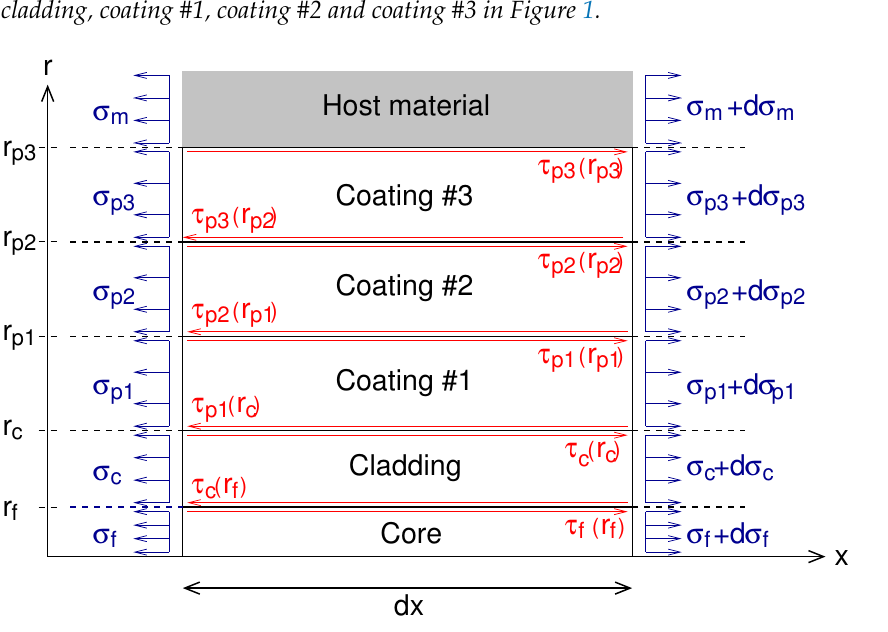
Figure 1. Schematic diagram showing the geometry of the optical fiber sensor embedded in a host material and the stresses used in the stress-strain